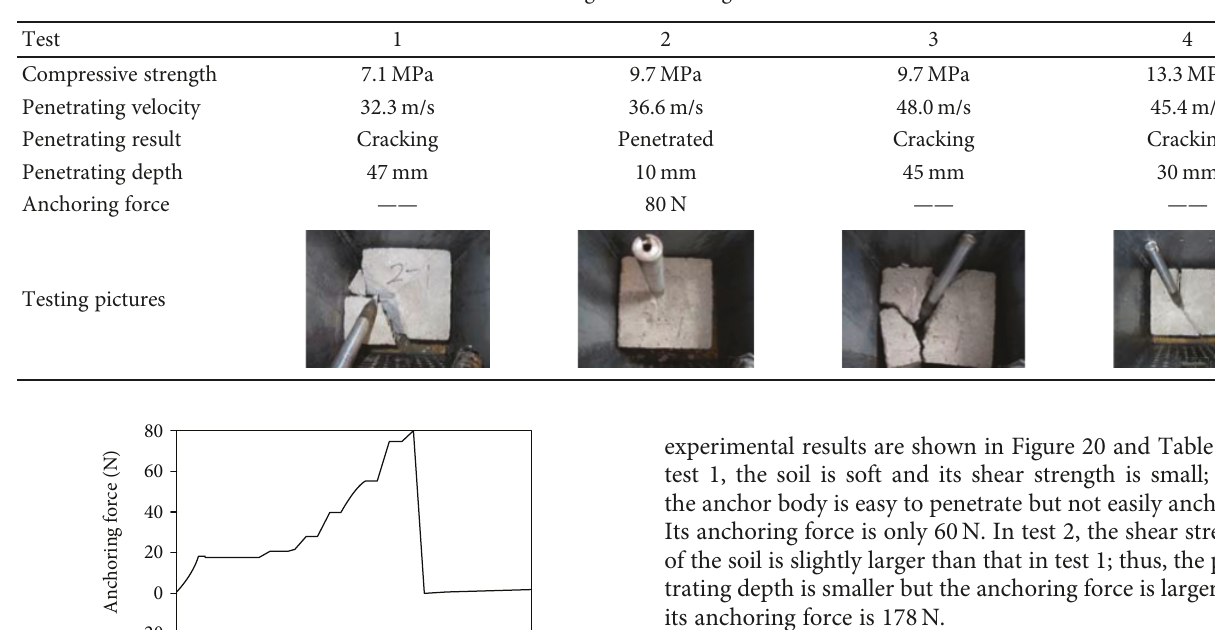
Table 3: Penetrating and anchoring tests in cement.